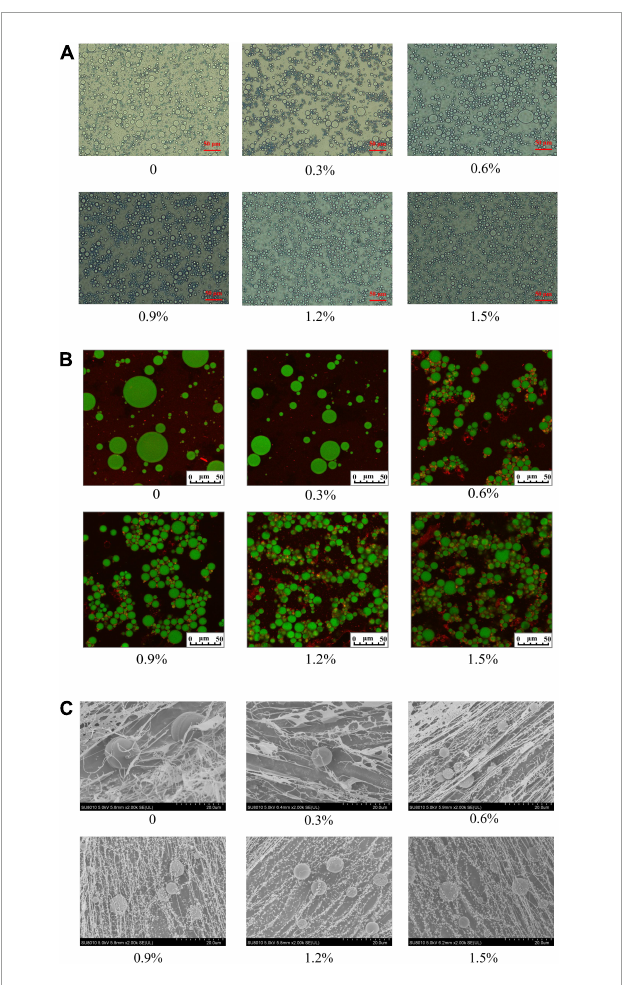
FIGURE7 The microstructure of the emulsions with different concentrations of compound fibers. Optical (A) , CLSM (B) and cryo-SEM (C) . The scale bar represents 50 µ